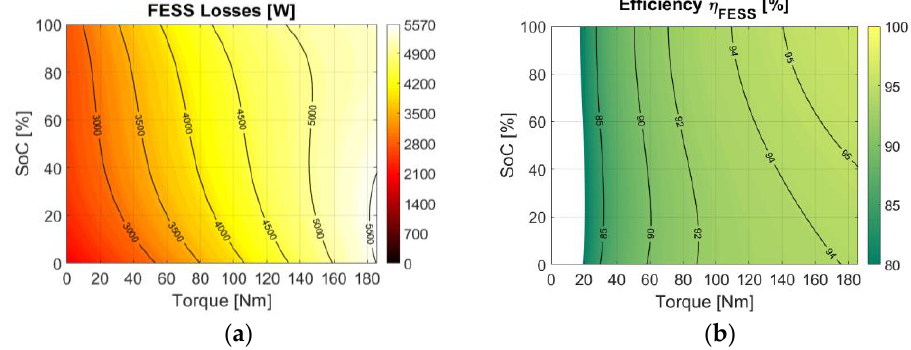
Figure 5. FESS maps with respect to the SoC and the mechanical torque on the electrical machine: ( a ) FESS loss map; ( b ) FESS efficiency map.